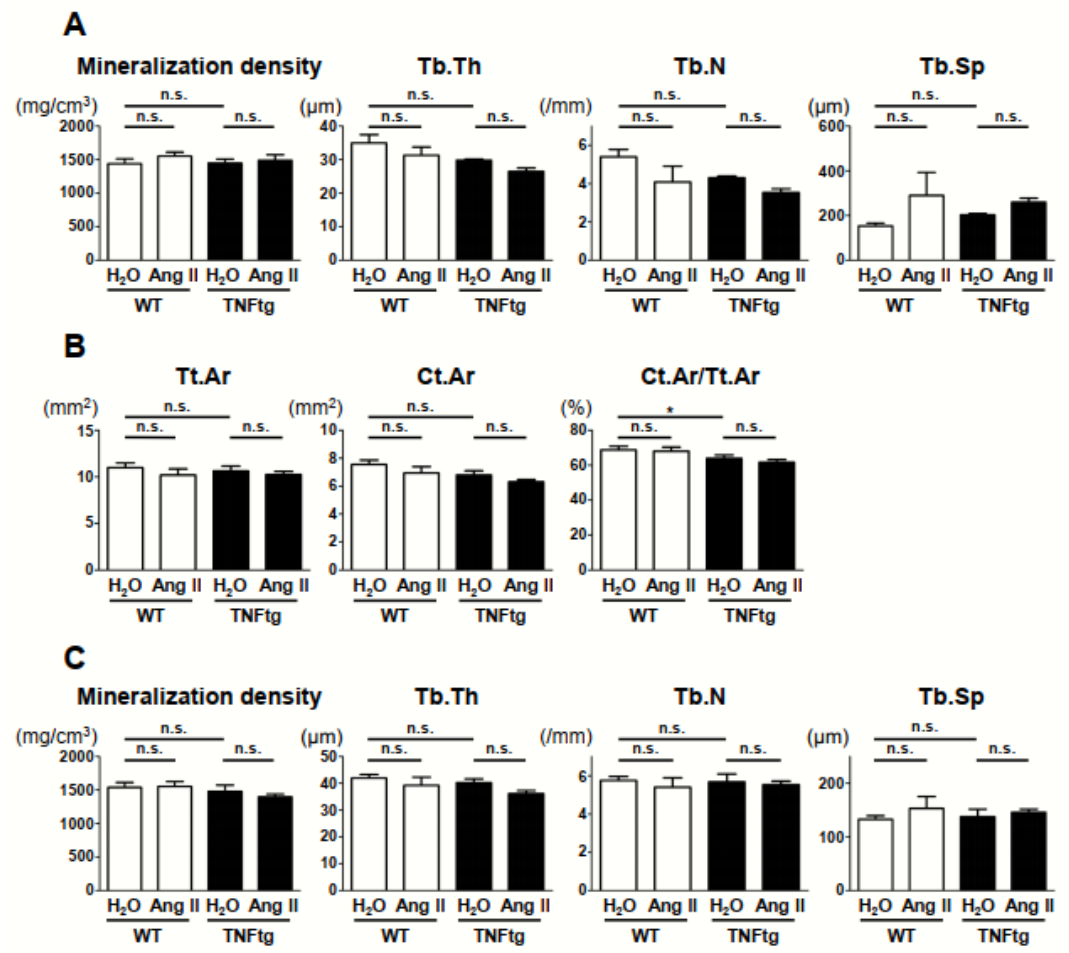
Figure A3. Trabecular and cortical bone parameters in wild-type (WT) and tumor necrosis factor-transgenic (TNFtg) mice administered angiotensin II (Ang II) and water (H 2 O). Ang II was administered by osmotic pumps to WT ( n = 6) and TNFtg ( n = 7) male mice from 12 to 16 weeks of age. H 2 O was administered by osmotic pumps to WT ( n = 6) and TNFtg ( n = 4) male mice as controls. ( A ) Trabecular bone parameters of the tibia. ( B ) Cortical bone parameters of the tibia midshaft. ( C ) Trabecular bone parameters of the spine (fifth lumbar vertebra). Tb.Th, trabecular thickness; Tb.N, trabecular number; Tb.Sp, trabecular separation; Tt.Ar, total cross-sectional area inside the periosteal envelope; Ct.Ar, cortical cross-sectional area. Values are the mean ± SEM. n.s., not significant. *, p < 0.05.